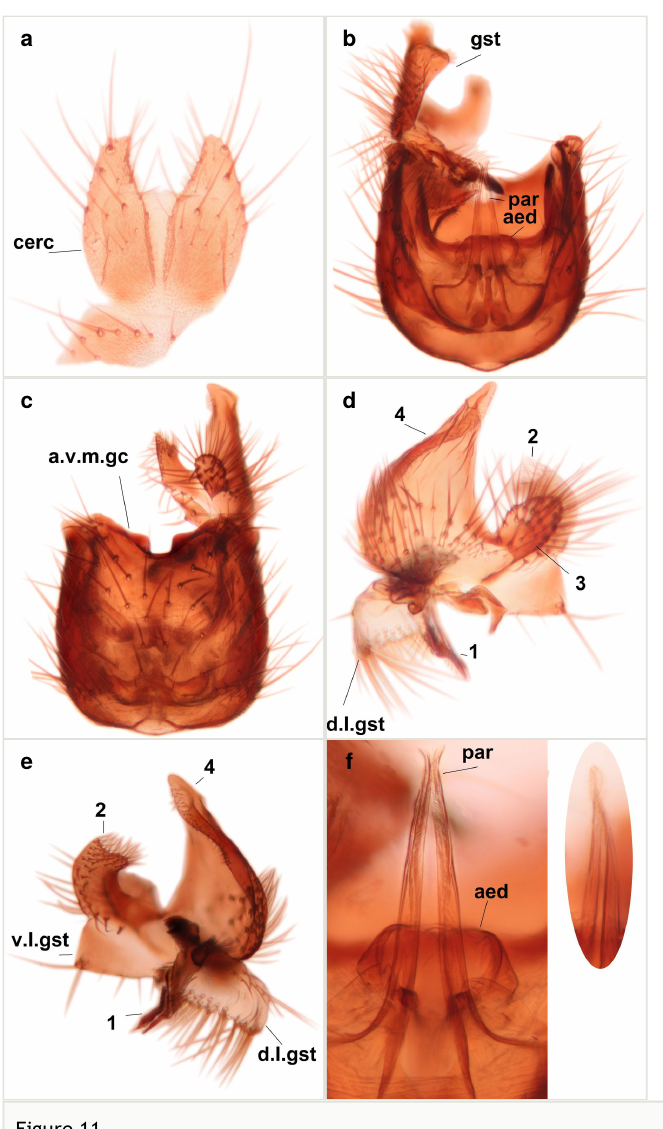
Figure 11. Phronia reducta Salmela sp.n., holotype male, hypopygium. a : Cerci (cerc), dorsal